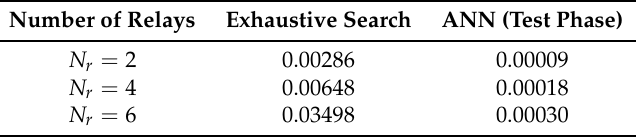
Table 2. Comparison of computation time